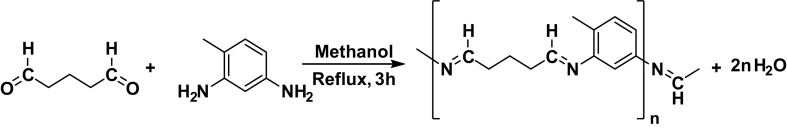
The structure of the synthesized polymeric Schiff base ligand.